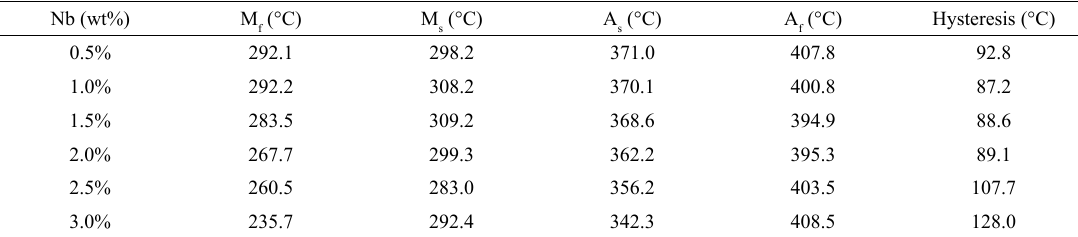
Table 1. Martensitic transformation temperatures and thermal hysteresis of the Cu-Al-Nb HTSMA samples. Nb